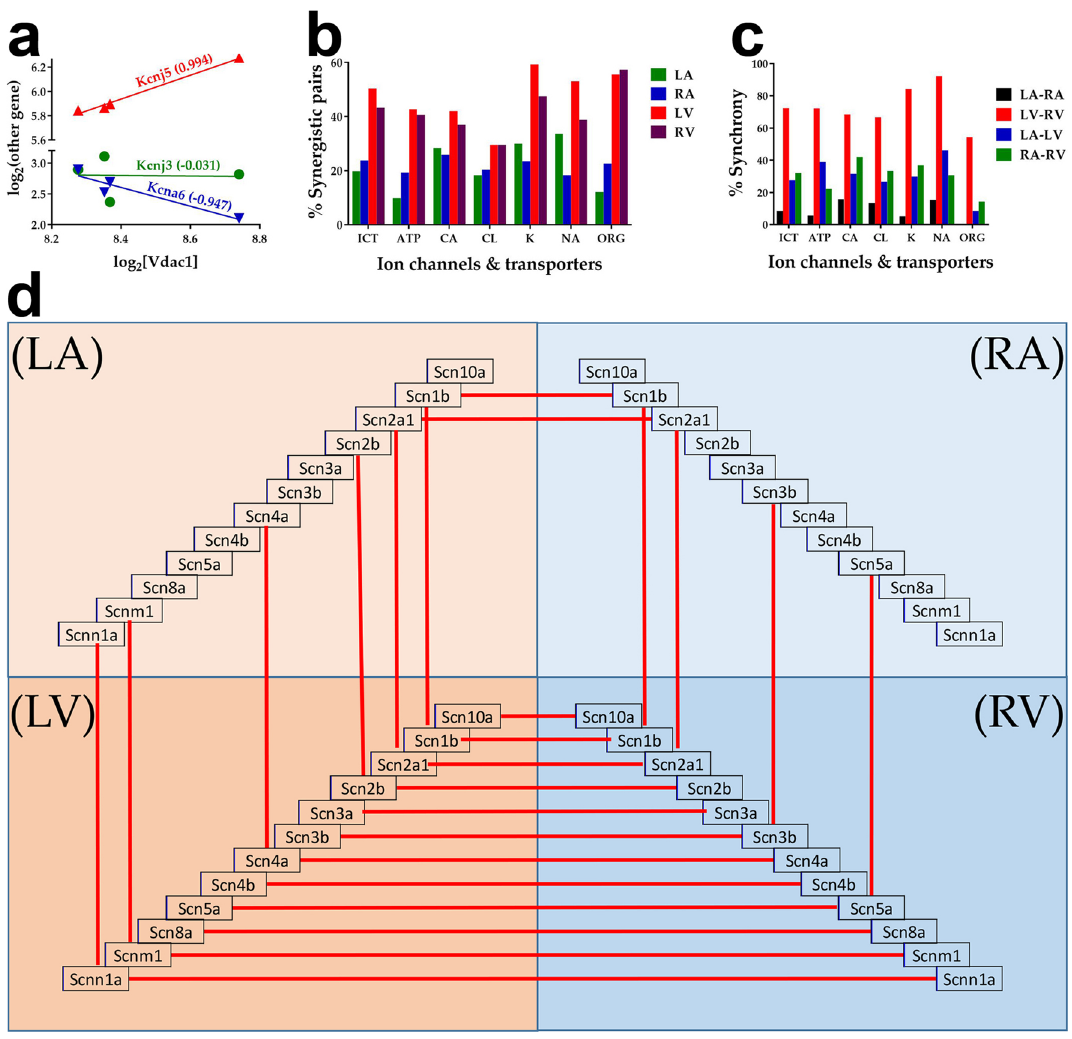
Figure 7. Correlation of the expressions of genes encoding ion channels and transporters (ICT). ( a ) Examples of synergistically ( Kcnj5 = potassium inwardly-rectifying channel, subfamily J, member 5), antagonistically ( Kcna6 = potassium voltage-gated channel, shaker-related, subfamily, member 6) and independently ( Kcnj3 = potassium inwardly-rectifying channel, subfamily J, member 3) expressed genes with Vdac1 (voltage- dependent anion channel 1) in the left atrium. ( b ) Percentage of synergistically expressed ion channel and transporter gene pairs within each chamber. ( c ) Synchronous expressions of ICT genes between two chambers. ( d ) Synchronous expressions of sodium channels in paired heart chambers are indicated by red lines linking the gene symbols. The correlation was computed for each ICT gene with each other ICT gene within the same chamber. ICT percentage out of all 17,020 pairs that can be formed with the quantified ICT genes, ATP transporting ATPases (1378 pairs), ORG transporters through organelle (mitochondria, lysosomes) membranes (903 pairs), CA calcium channels (153 pairs), CL chloride channels (91 pairs), NA sodium channels (91 pairs), K potassium channels (1596 pairs). Note the significantly larger percentages of synergistically expressed pairs of ion channels and transporters in the